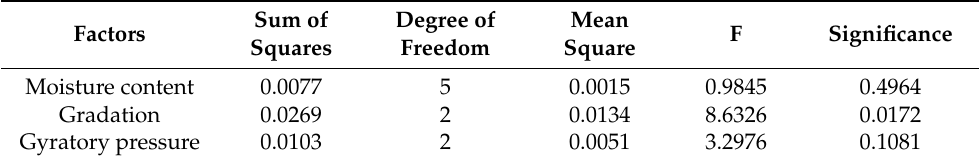
Table 3. The variance statistics from gyratory compaction tests with orthogonal array testing matrix.